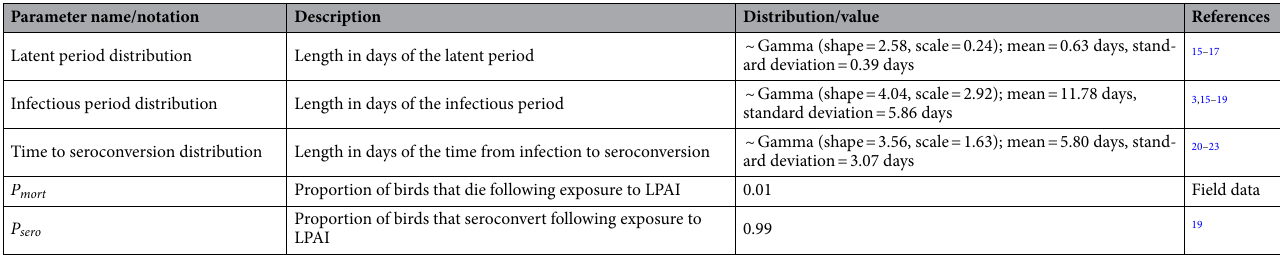
Table 1. Input parameters for the stochastic within-house LPAI transmission